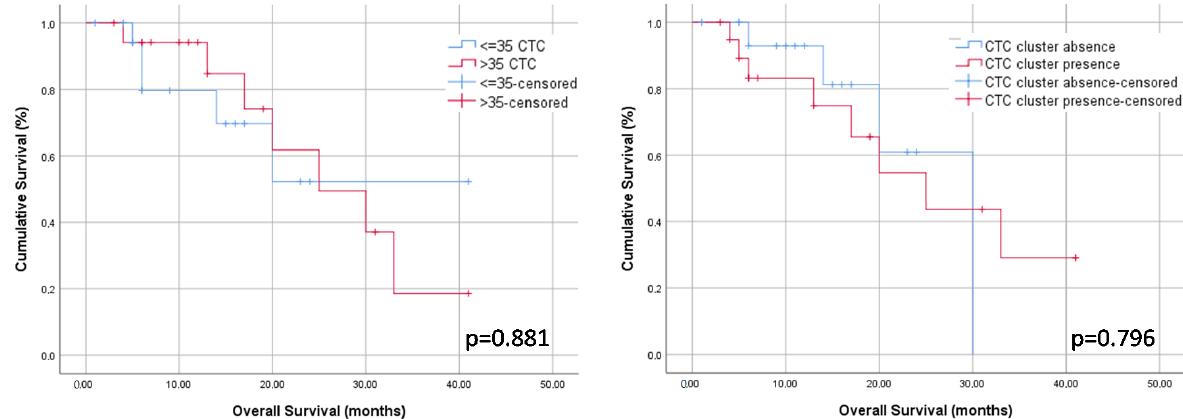
Figure 2. Kaplan–Meier curves (long-rank test) showing transplant-free survival rates according to baseline CTC count ( left panel) and baseline presence of CTC clusters ( right panel).